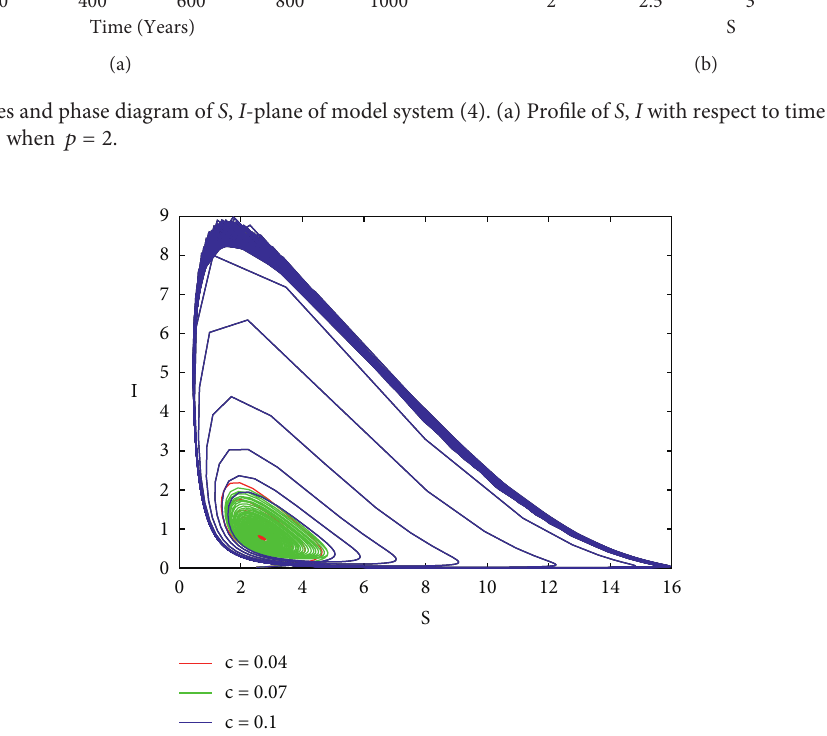
Figure 7: The phase diagram of S and I planes with different values of saturated recovery c . Here, there are two limit cycles. The inner one is unstable and the outer one is